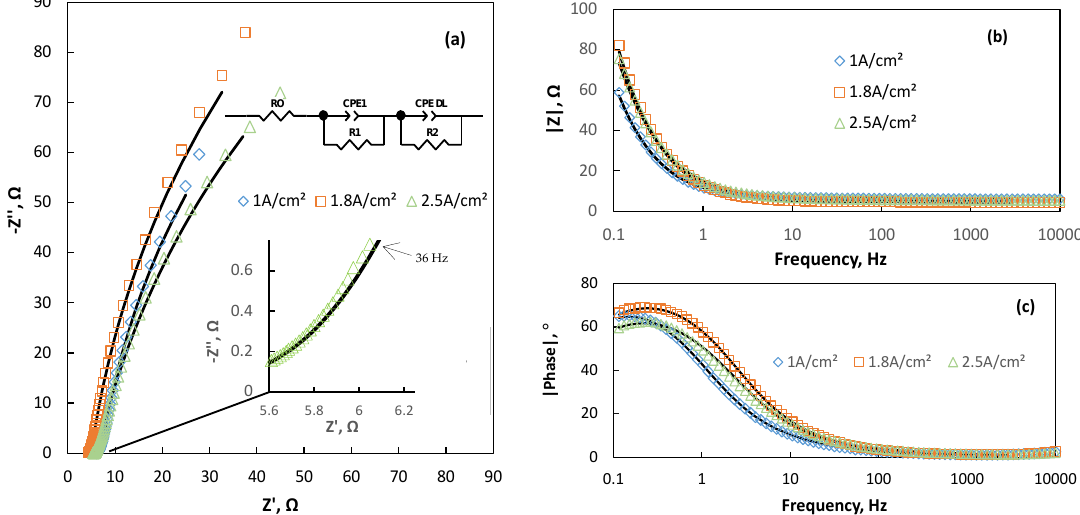
Figure 7. EIS data of cobalt foams measured in 0.1 M Na 2 SO 4 at − 1.0 V vs Ag / AgCl, foams deposited from solution 4, q = 180 C, EIS data represented in: ( a ) Nyquist’s coordinates, ( b ) Bode modulus, and ( c ) Bode phase modulus coordinates. The equivalent electric circuit used for fitting is presented in the insert; points–experimental data, solid lines–results of fitting to the shown equivalent electric circuit. Table 2. Values of elements of the equivalent electric circuit fitted EIS data obtained in 0.1 M Na 2 SO 4